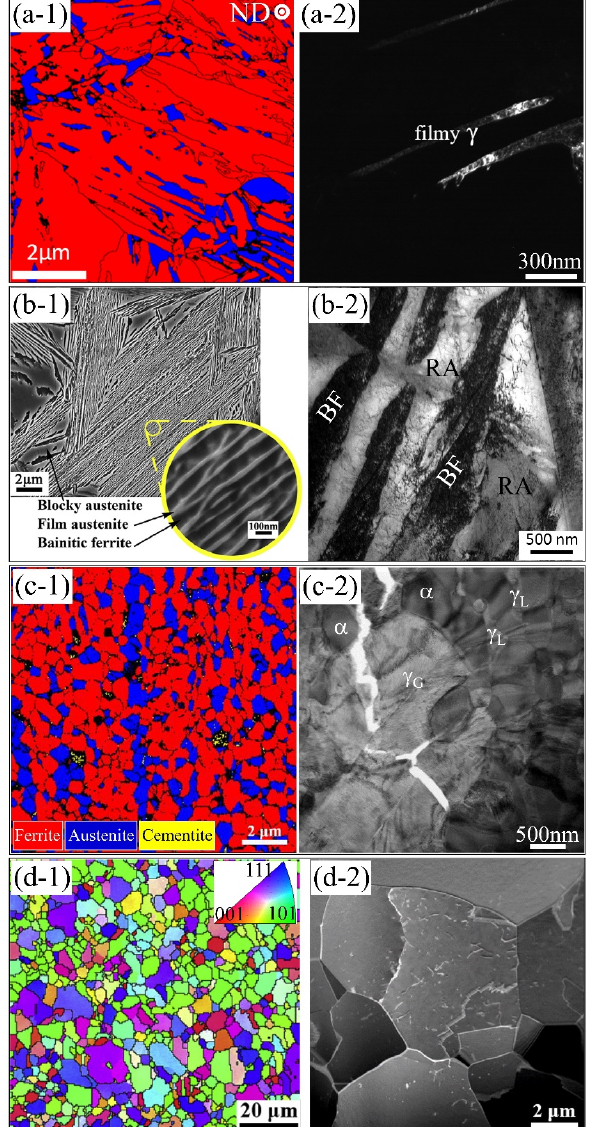
Figure 1. Microstructure of different AHSS containing the metastable austenite grains, including the ( a ) Q&P steel [56], Reprinted with permission from ref. [56]. Copyright 2018, Elsevier. ( b ) CFB steel [57,58], Reprinted with permission from ref. [57,58]. Copyright 2015, 2017, Elsevier. ( c ) medium Mn steel [59,60], Reprinted with permission from ref. [59,60]. Copyright 2019, 2021, Elsevier. and ( d ) TWIP steel [61,62]. Reprinted with permission from ref. [61,62],. Copyright 2015, 2016, Elsevier. ( a-1 ) and ( c-1 ) are EBSD phase map; ( b-1 ) is SEM image; ( d-1 ) is EBSD orientation map; ( a-2 ) to ( d-2 ) are TEM images. Red color and blue color in ( a-1 ) represent the martensite and austenite, respectively. ND: normal direction. γ G : granular austenite; γ L : lamellar austenite; α :